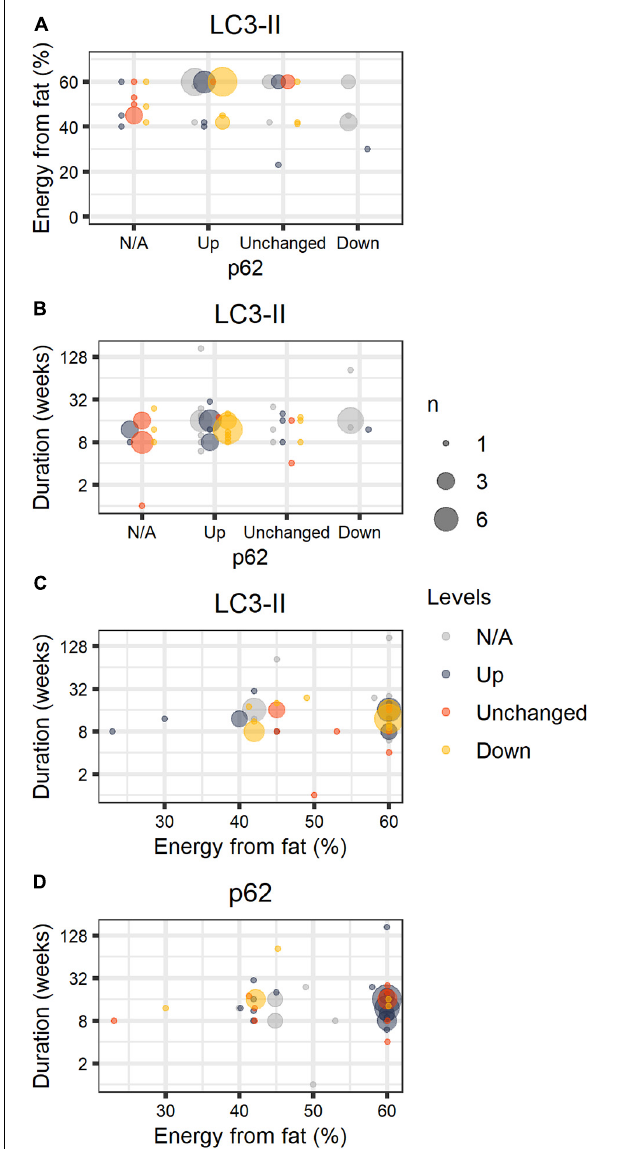
FIGURE 1 | HFD papers. Number of journal articles ( n ) describing diet fat content (in percentage of energy), duration of the intervention, and LC3-II and p62 protein levels in the liver in comparison to control groups (chow or LFD), normalized by a housekeeping protein. LC3-II and p62 were estimated by the authors through SDS-PAGE Western blots and described semi-quantitatively or qualitatively. The size of the circle corresponds to the total number of articles with the same description. Colors refer to LC3-II (A–C) or p62 (D) qualitative status. [gray = N/A (not available), blue = Up, orange = Unchanged, yellow =